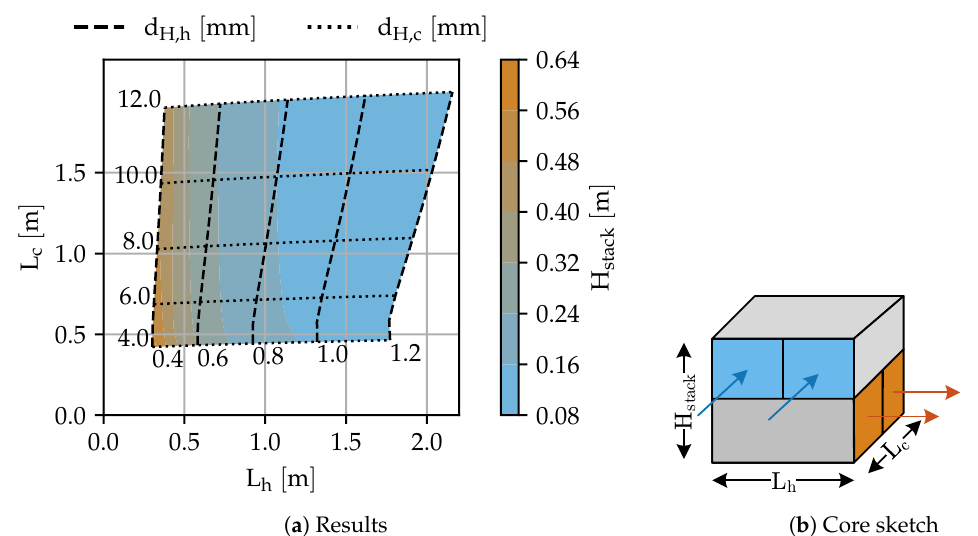
Figure 9. Heat exchanger size sensitivity in three dimensions: hot-side length, cold-side length, and stack height over hot- and cold-side hydraulic diameter.